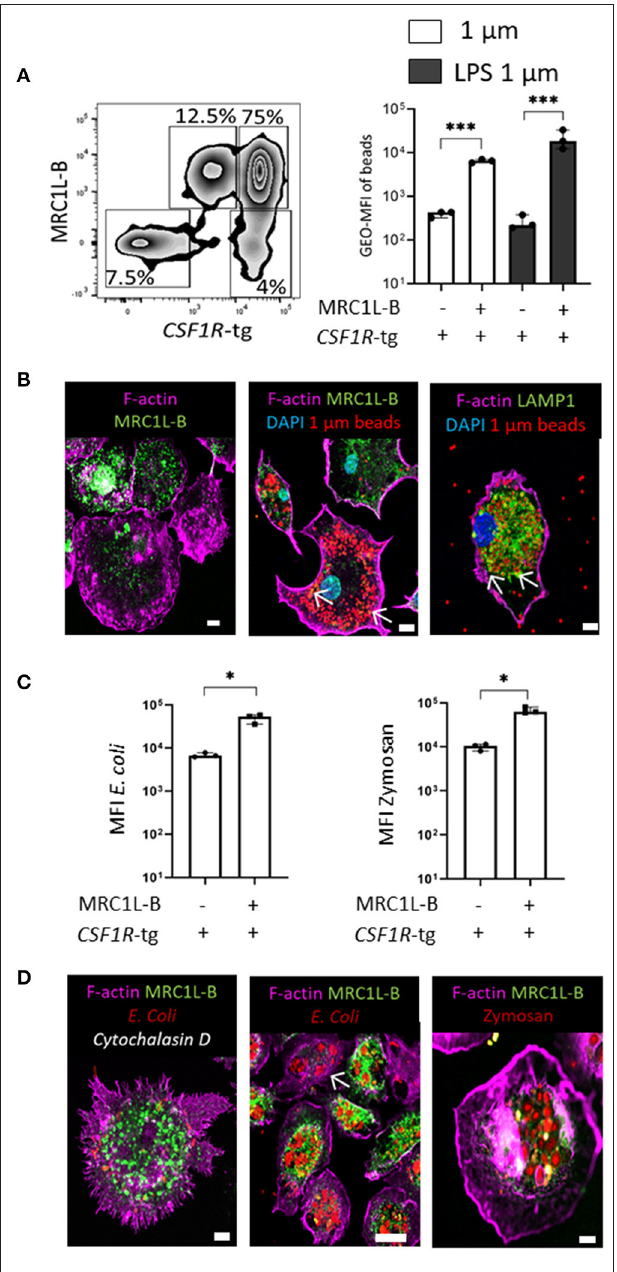
FIGURE 7 | In vitro functional analysis demonstrates the ability of the CSF1R -tg + MRC1L-B neg cDC to phagocytose model antigens. Splenocytes were culture for 48h in the presences of CSF1 and phagocytosis was analyzed 3h post-treatment via flow cytometry. (A) After 48h in culture, CSF1R -tg hi MRC1L-B hi are the dominant subpopulation (75%) compared to the CSF1R -tg dim MRC1L-B hi (12%), CSF1R -tg hi MRC1L-B neg (4%), and CSF1R -tg neg MRC1L-B neg subpopulations (7.5%). MFI of unlabeled and LPS labeled 1 µ m beads was significantly higher in the C SF1R -tg + MRC1L-B + subpopulation compared to the CSF1R -tg hi MRC1L-B neg cell population 3h post-bead treatment; (B) confocal analysis demonstrates the (i) adherence of the MRC1L-B hi and MRC1L-B neg cells after 48h in culture; (ii) MRC1L-B + cells phagocytose numerous beads and it expression is localized with internalized beads (white arrows); (iii) intracellular LAMP1 expression co-localizes with (Continued)